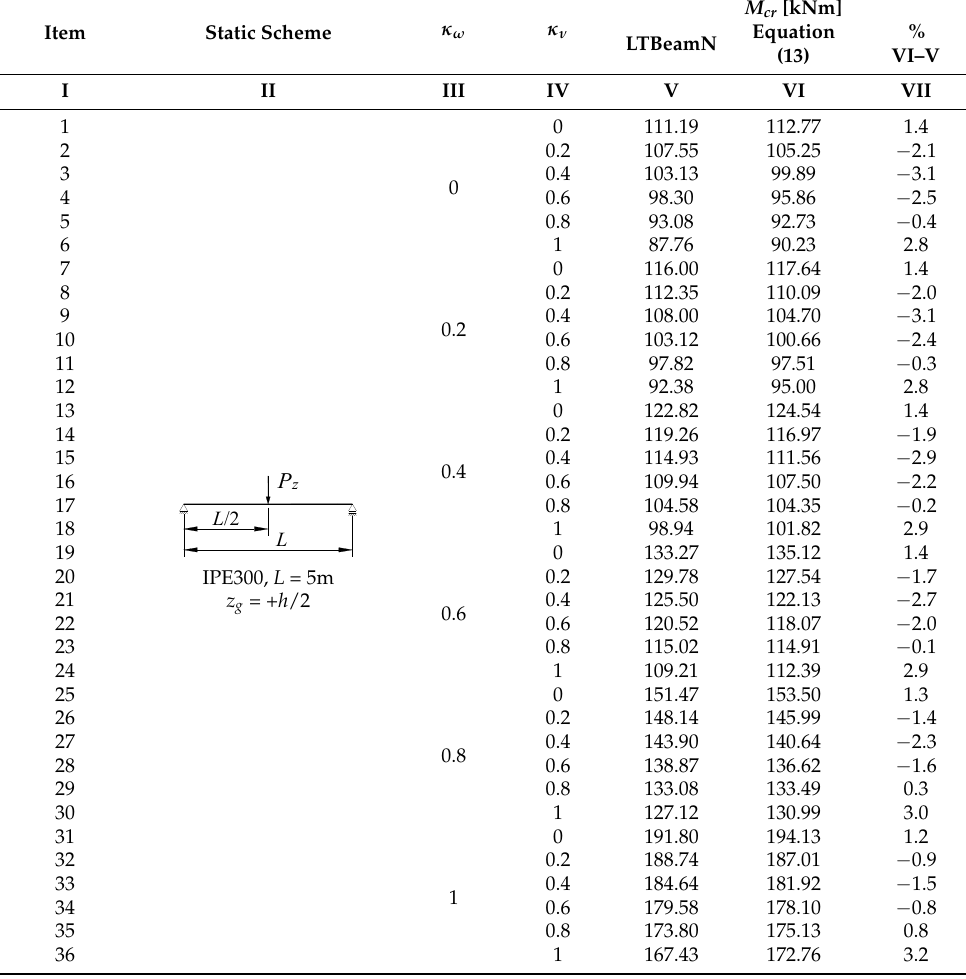
Table 6. Comparison of M cr for beam IPE300 ( L = 5 m).